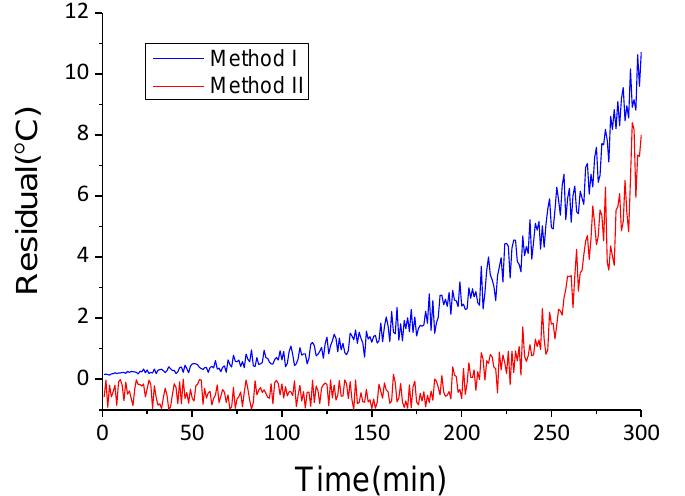
Figure 11. Residual results of Method I and II in main bearing offset failure.